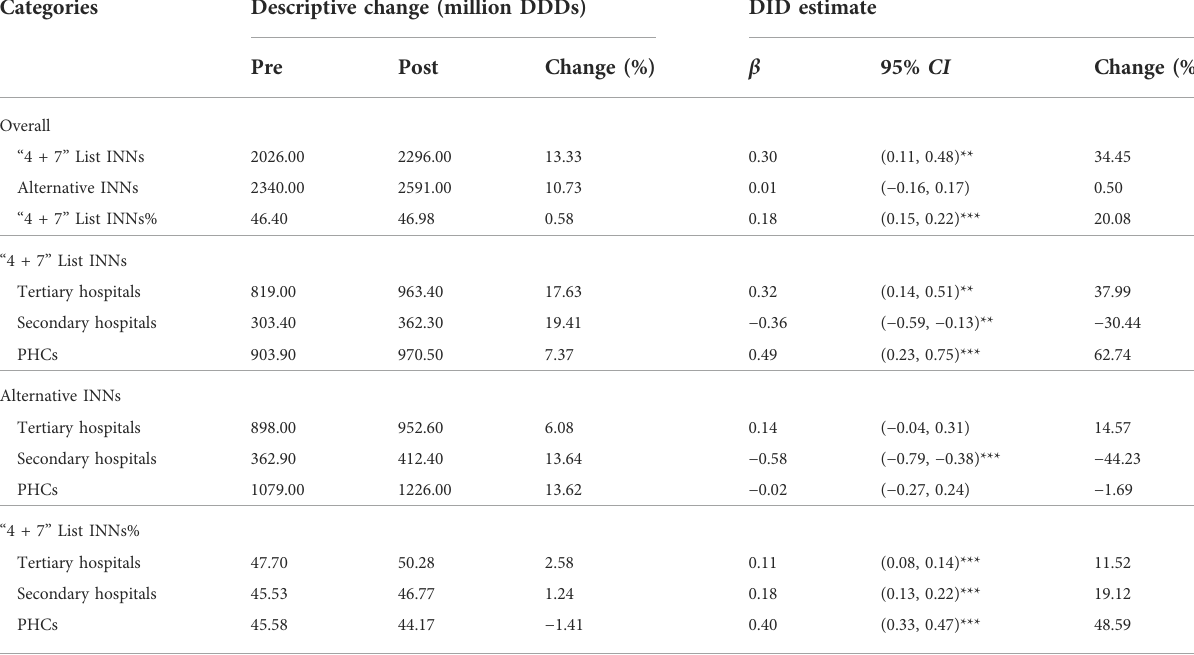
TABLE 4 Impact of the “ 4 + 7 ” pilot on monthly volumes of “ 4 + 7 ” List drugs and their alternative drugs, strati fi ed by healthcare